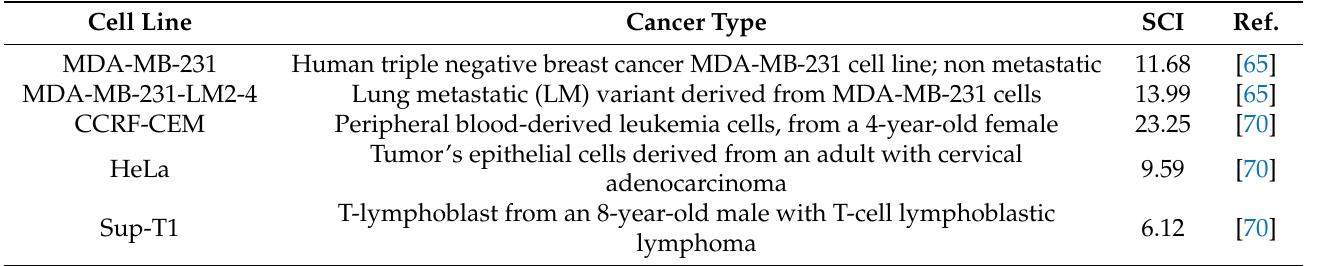
Table 1. Selective cytotoxicity index (SCI) of lactoferrin against different cancer cells. Cell Line Cancer Type SCI